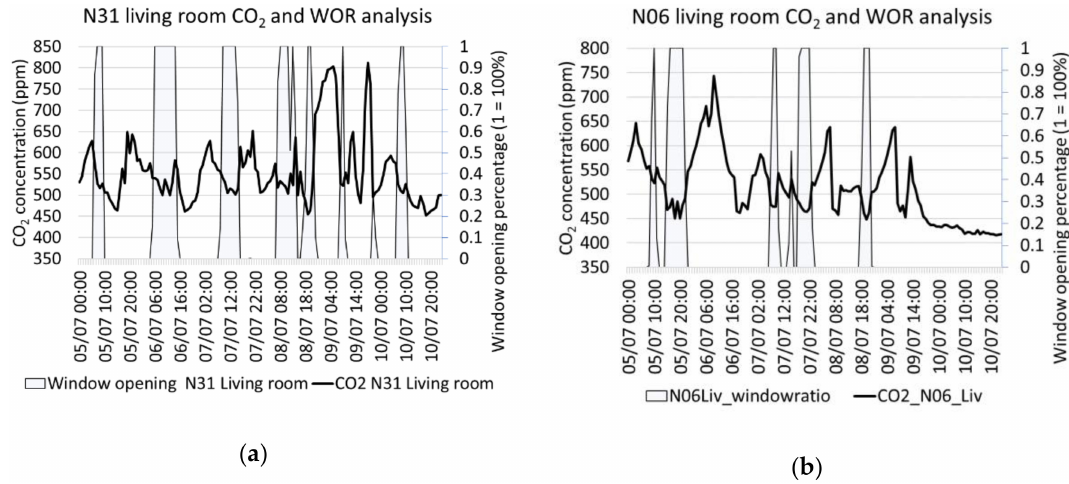
Figure 14. CO 2 concentration and window opening in living rooms: ( a ) Flat N31; ( b ) Flat